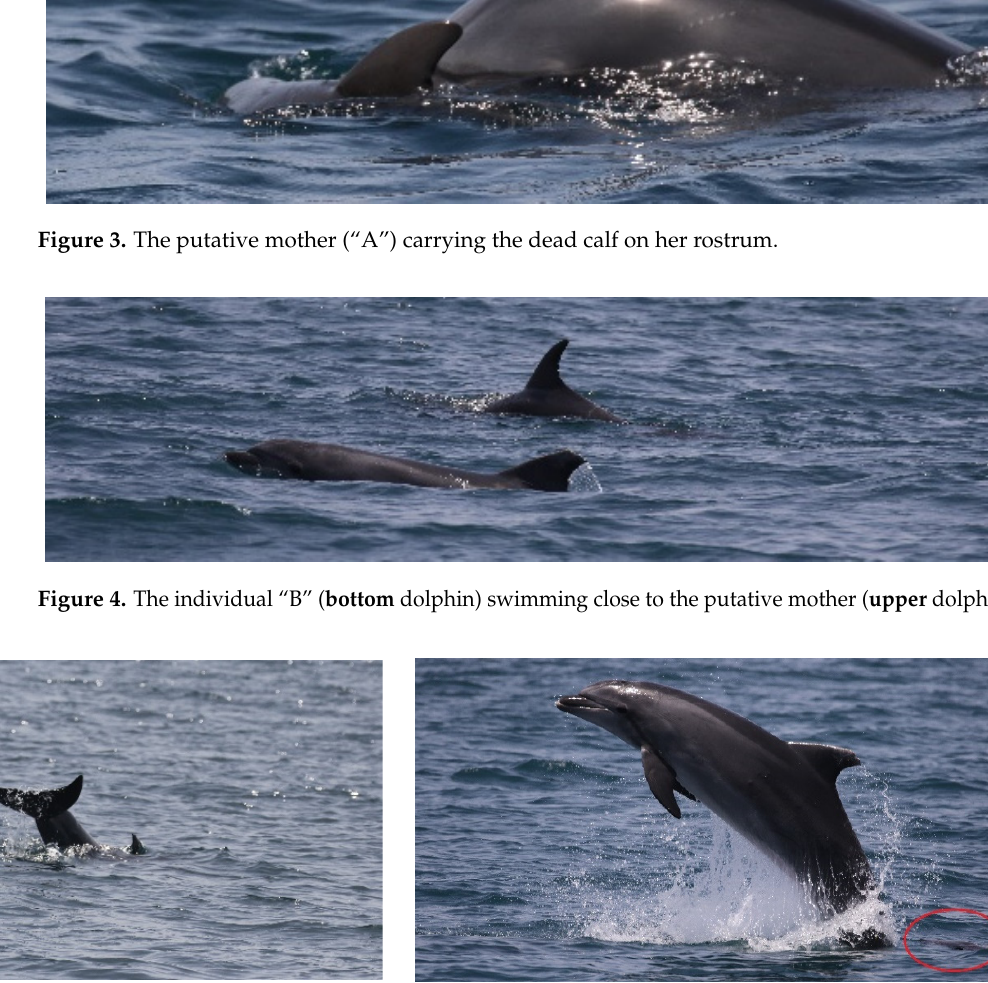
6 of 15 Figure 2. Left picture: the dead new ‐ born with visible fetal folds. Right picture: Edge of the new ‐ born tail visibly marked . “A” spent most of the time carrying the carcass on its rostrum and trying lift it, bring ‐ ing the dead body to the surface, and pushing it up with the rostrum repeatedly every time it sunk. (Figure 3). Considering the time that “A” spent in supportive behavior to ‐ ward the dead calf, we presumed this animal to be the mother. The other individual “B” remained close during the entire sighting, swimming around the pair without directly providing aid most of the time (Figure 4) and showing several behaviors typical of arousal states such as tail ‐ slapping (Figure 5, left picture) or leaping close to the carcass (Figure 5, right picture). During one of the leaps, the genital area of the animal briefly appeared, allowing us to presume this individual to be a putative male, although we did not manage